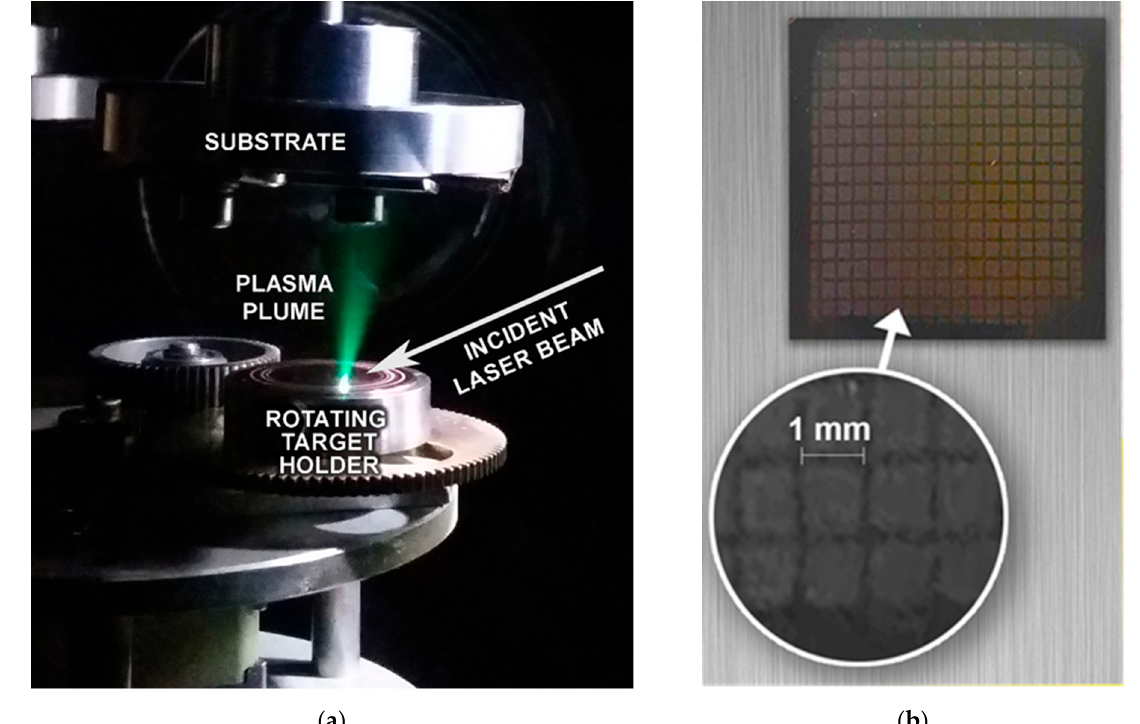
Figure 1. ( a ) The plasma plume expansion during ablation; ( b ) the mesh used for defining the array of patterns deposited.